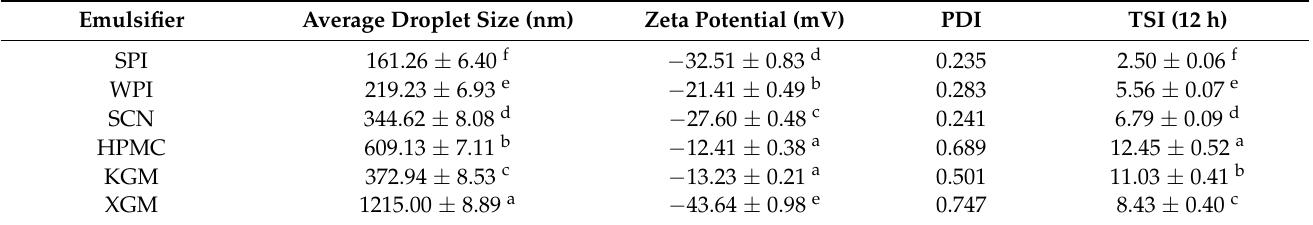
Table 2. The droplet size, zeta potential, polydispersity index (PDI) and Turbiscan stability index